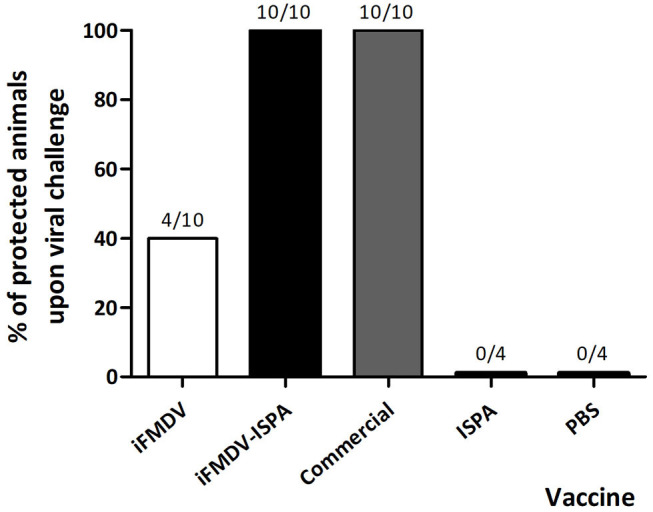
Protection on viral challenge elicited by different vaccines. Groups of mice (n = 10) were vaccinated with iFMDV, ISPA-iFMDV, or a commercial FMD vaccine, and groups of mice (n = 4) were vaccinated with ISPA or PBS alone, and challenged with infective FMDV at 21 dpv. Protection was calculated as described for Figure 2. Results are representative of two independent experiments.